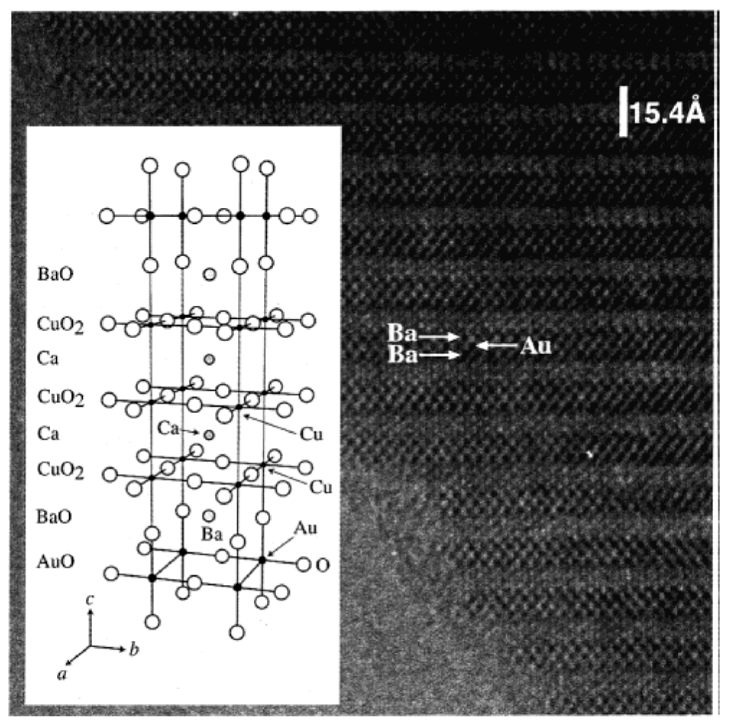
Figure 3. HRTEM image of Au-1223 phase taken along (100) zone axis. The structure model of Au-1223 is shown in the inset. Reproduced with permission from [10].